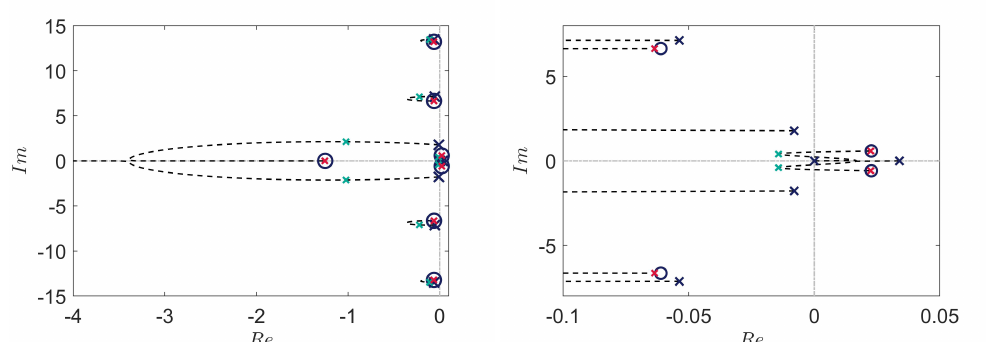
Figure 4. Low-frequency part of root locus of closed-loop system ( left ) and its zoomed-in view for the 4 low-frequency modes ( right ). Poles of the open-loop system (blue), poles of the closed-loop system with k P = 405 (green), poles of the closed loop system with k P = 2 × 10 5 (red).